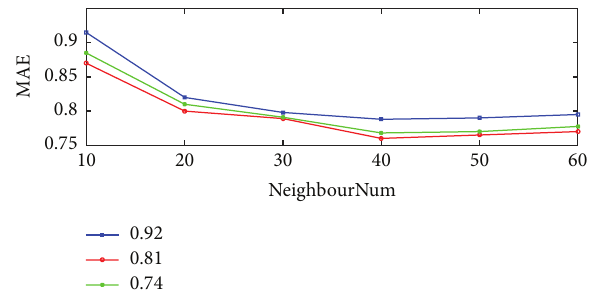
Figure 4: Analysis of HF in recommendation accuracy.